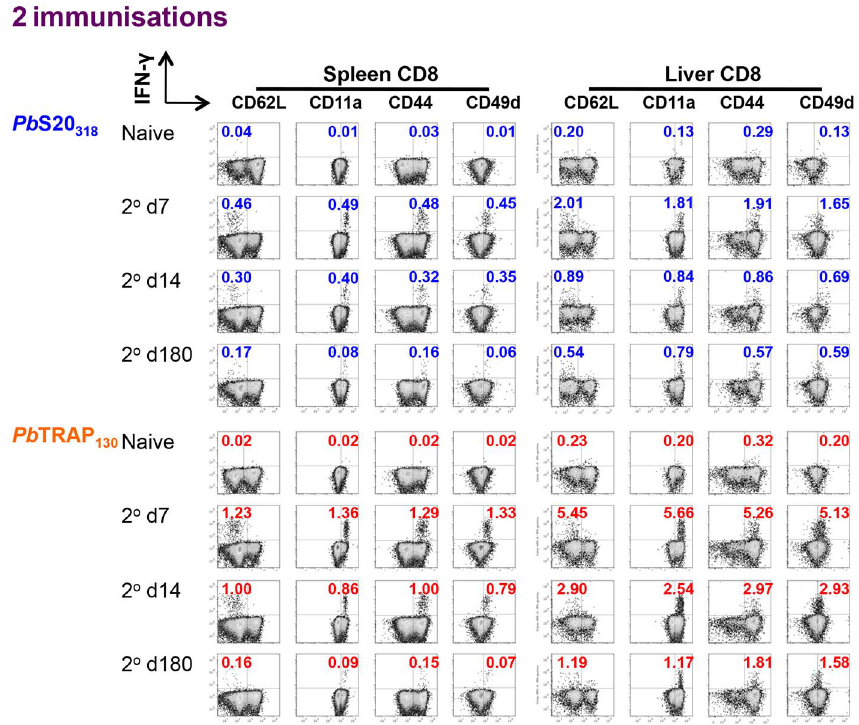
Figure 3. Phenotyping Pb S20 318 and Pb TRAP 130 -specific CD8 + T cell responses. B6 mice were immunised twice with Pb c -Spz (see Figure 2A). On days 7, 14 and 180 after the last immunisation, Pb S20 318 and Pb TRAP 130 -specific CD8 + T cell responses were quantified in the spleens and the livers by peptide stimulation followed by ICS. Figure shows flow cytometry plots of IFN- c co-staining with markers of effector and effector memory phenotypes (CD62L lo , CD11a hi , CD44 hi and CD49d hi ).